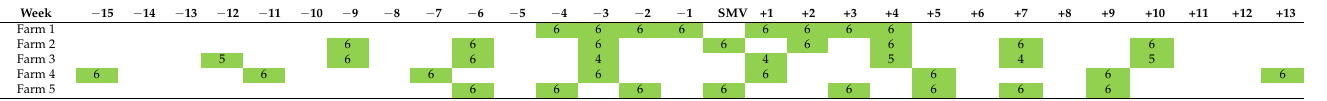
Table 2. Summary of PCR results in all of the farms during the study.